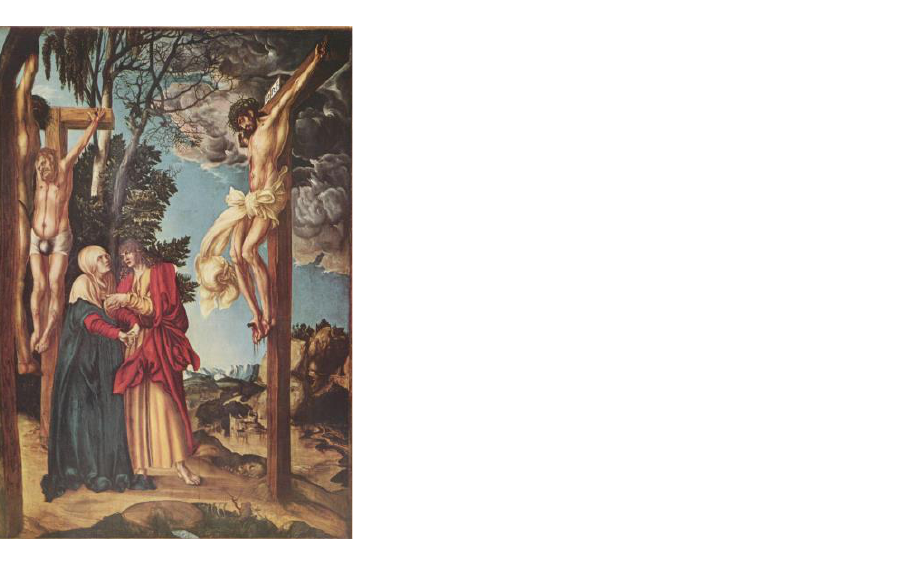
Figure 1. The Lamentation of Christ , painted in 1503 (Figure 1, in black paint on a piece of white paper painted as a tromp l ’ oeil at the bottom edge of the painting, 137.8 – 138 × 98.3 – 99.3 × 0.8 – 1.5 cm. https://lucascranach.org/en/DE_BStGS_1416/, accessed on 27 February 2023).